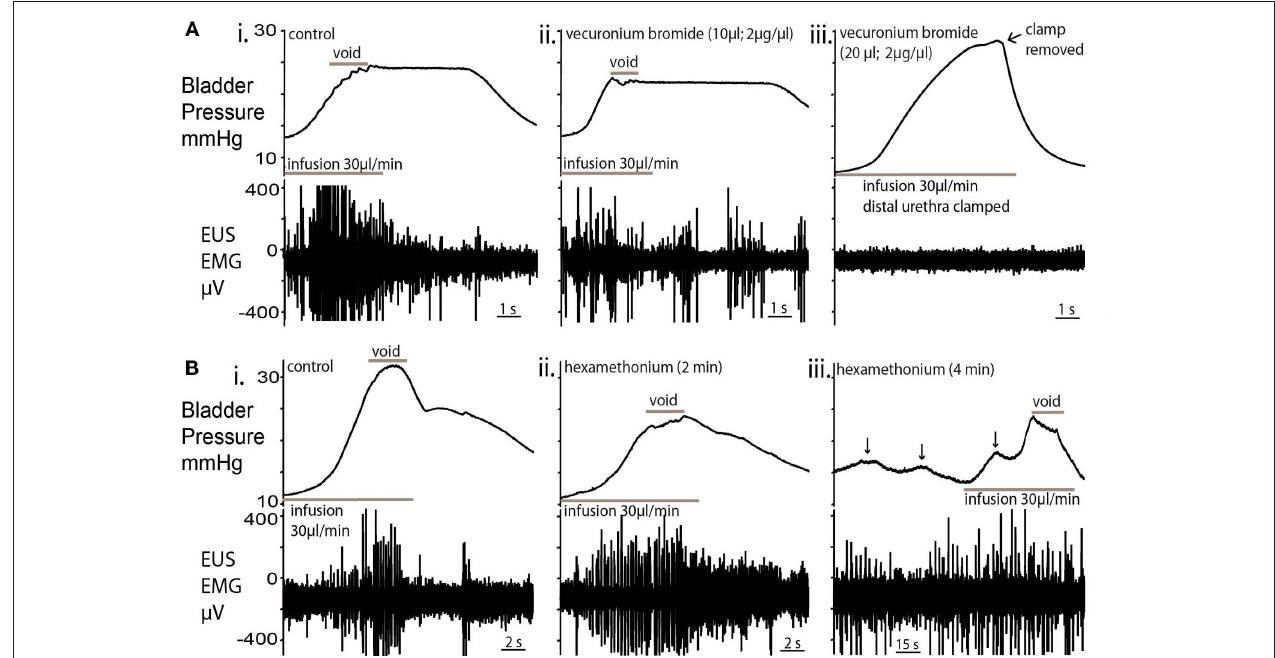
maintained for the following 30 min without sign of recovery. (B) Application of the ganglion blocker hexamethonium [330μM; (ii)] to the perfusate blocked the cardiovascular responses to peripheral chemoreflex activation indicating that the sympathetic and parasympathetic outflows were blocked. There was an initial decrease in the voiding pressure, although the characteristic pressure trajectory and EUS bursting activity remained. (iii) After a further 2 min, NMCs became larger (arrowed) in amplitude, with associated EUS activity to maintain continence. Voiding was present, but altered, with low voiding pressure and high baseline intravesical